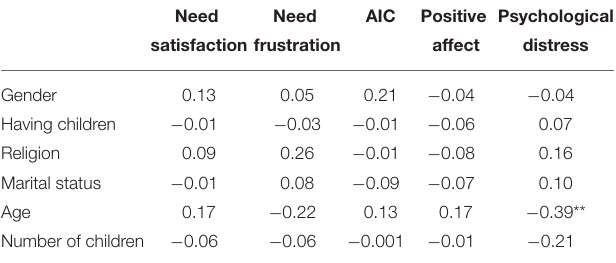
TABLE 2 | Correlations between socio-demographic and study variables.